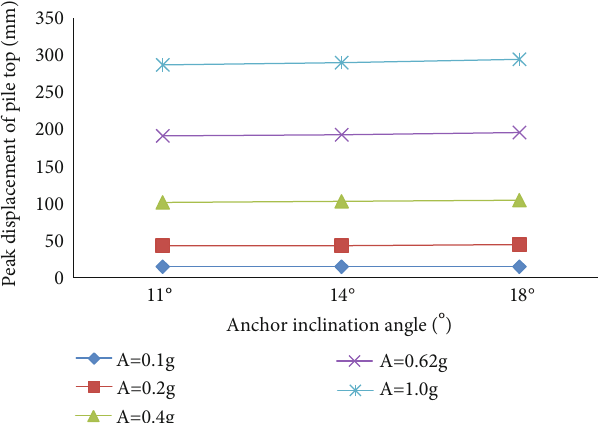
Figure 6: Distribution of the peak displacement of the pile top against the anchor inclination angle under the same working conditions.